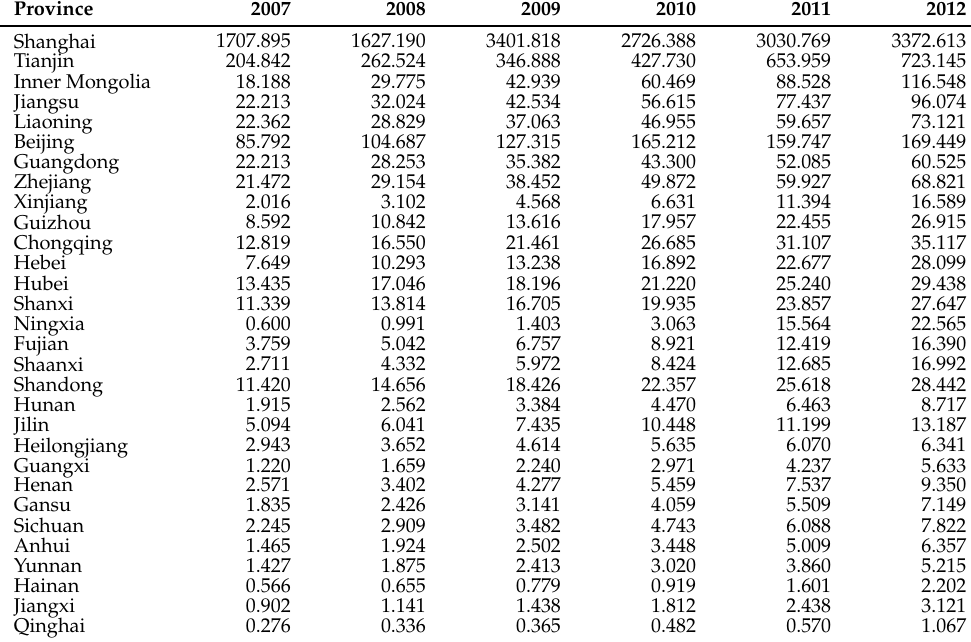
Table A11. The intra-provincial carbon inequality estimation results of original carbon emission data based on a 5-year rolling window for 30 provinces in China from 2007 to 2012.